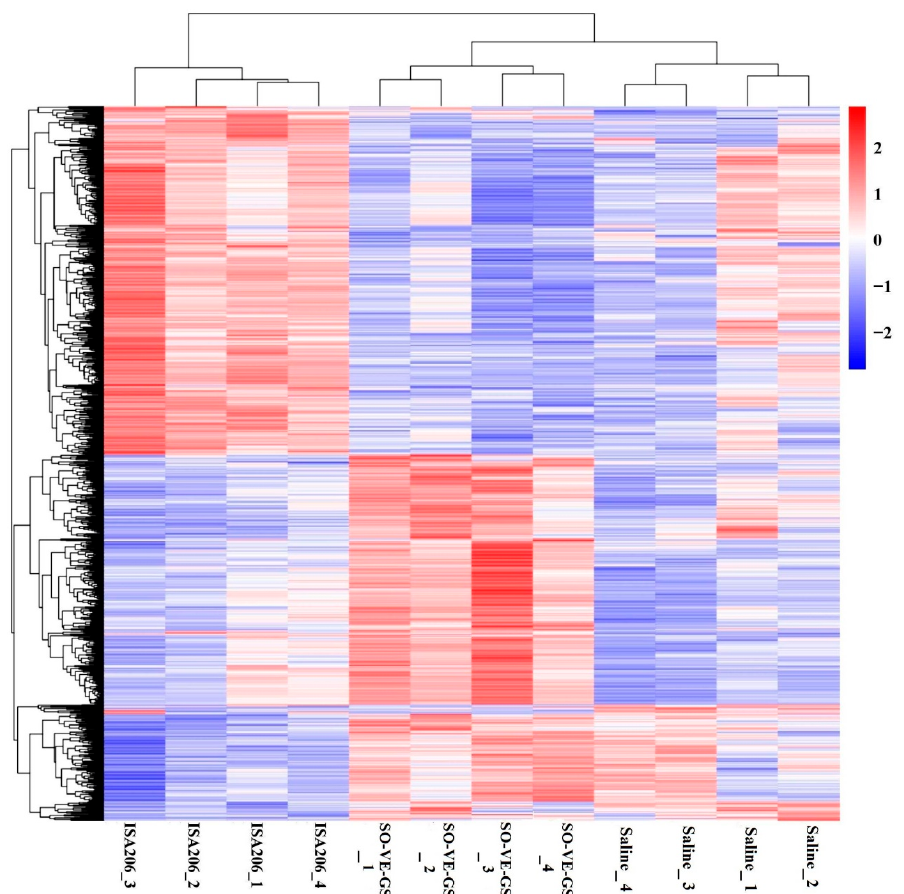
Figure 7. Heat map of hierarchical clustering of genes expressed in splenocytes from mice ( n = 4/group) i.m. immunized twice at a 2-week interval with the FMDV antigen in saline or adjuvanted with SO-VE-GS or ISA206. The P values were adjusted using the Benjamini & Hochberg method. Corrected P -value of 0.05 and absolute fold change of two were set as the threshold for significant differential expression. The color key indicates reads per kilobase per million reads normalized log2 transformed counts. The red color represents high expression. The blue color represents low expression.